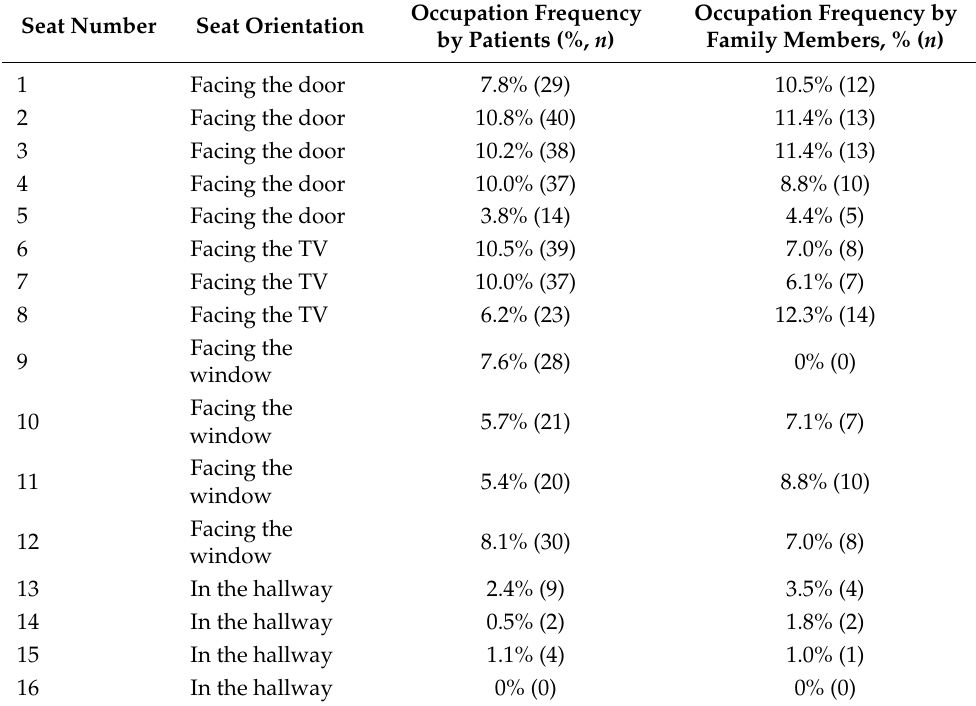
Table 4. Frequency of Chair Selection for patients and family members.